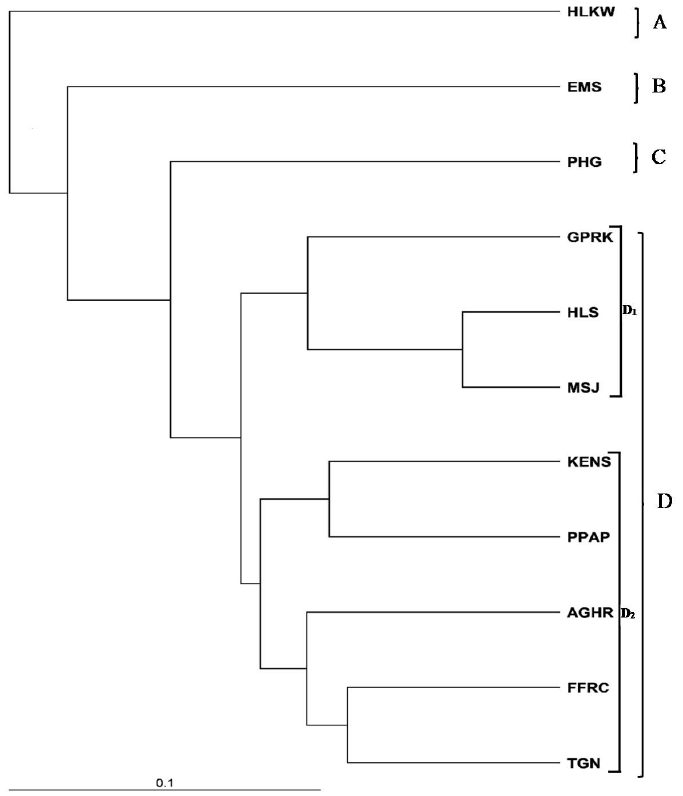
Figure 2. UPGMA dendrogram generated based on Nei’s (1983) genetic distance; HLKW: Kelah